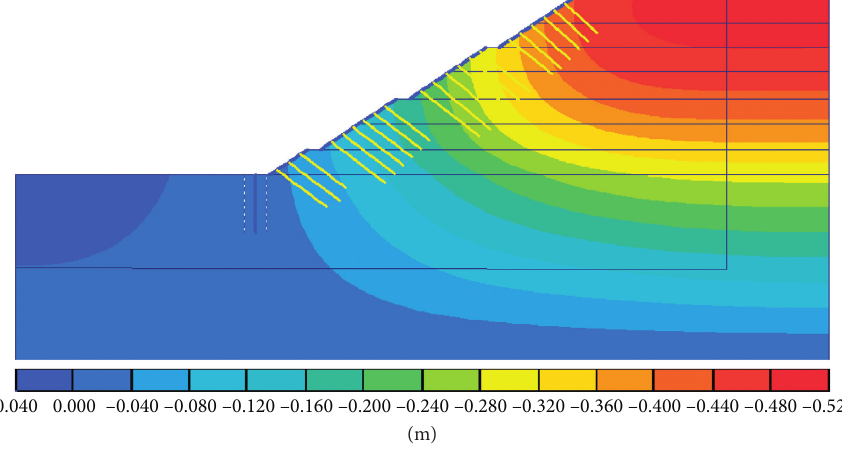
Figure 9: Vertical displacement nephogram of slope working condition 8 under reinforcement